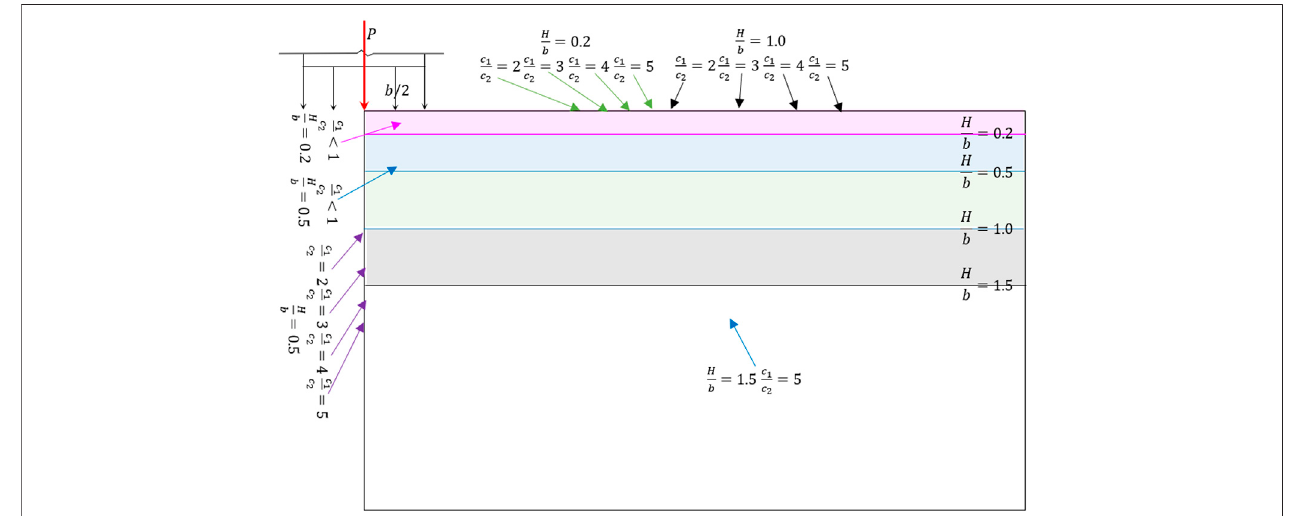
FIGURE 10 | Typical failure